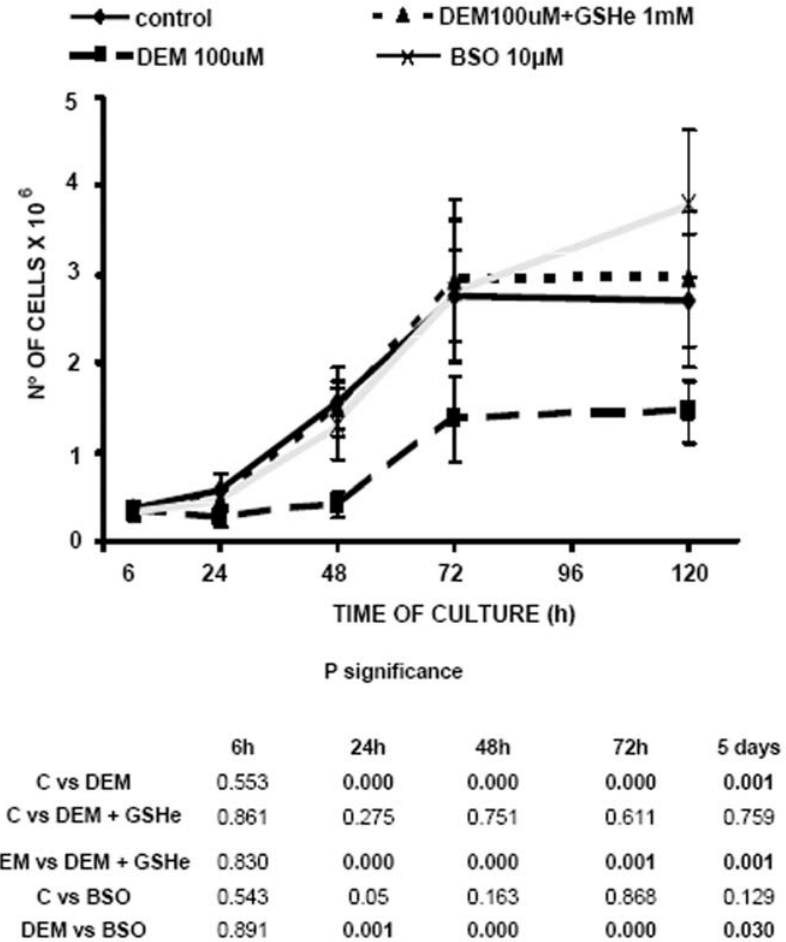
Figure 1. Comparison of the effect of GSH depletion by DEM and BSO on cell growth. Cells were plated and after attaching, treated with 100 m M DEM, or 10 mM BSO, or 100 m M DEM + 1 mM GSHe. At 6 h, 24 h, 48 h, 72 h, and 5 days of culture cells were detached by trypsinization and counted. The proliferation curves are created on the basis of the mean 6 SD of 6–16 different experiments.